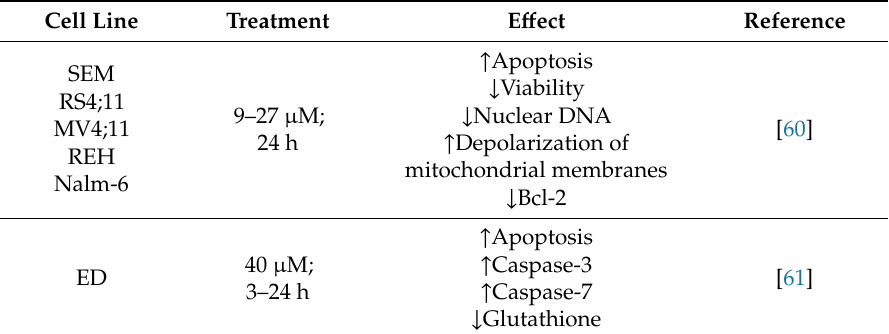
Table 7. E ff ects of carnosol on leukemia in